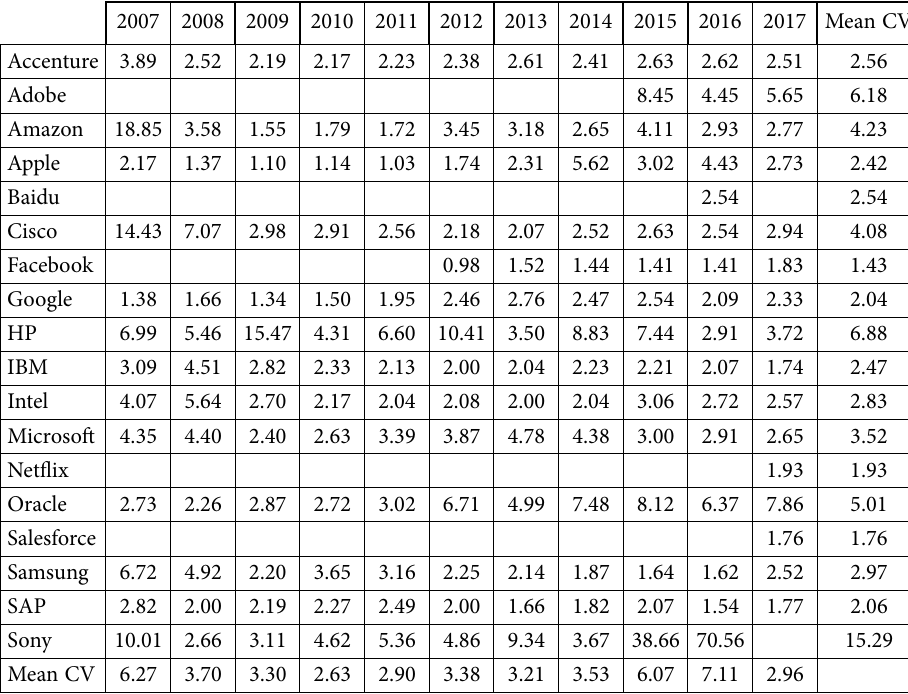
Table 3. The CVs of the brand rankings’ scores for each brand and year for the high-value brands of the IT sector 2007 2008 2009 2010 2011 2012 2013 2014 2015 2016 2017 Mean CV Accenture 3.89